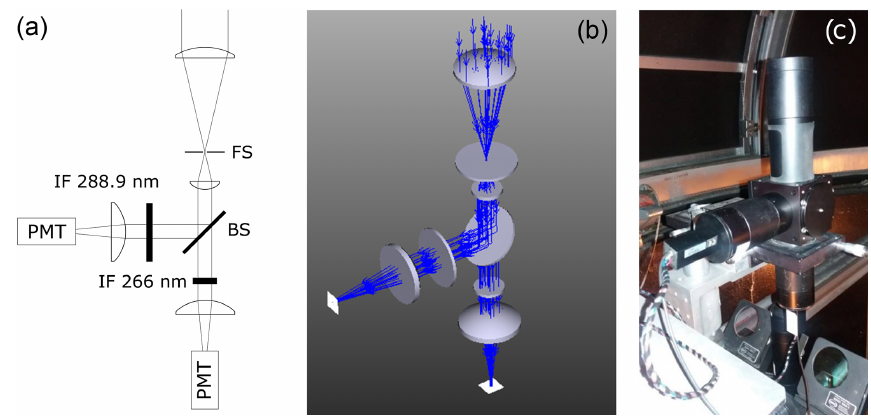
Figure 6. (a) Scheme of the new very near-range receivers. BS is a pellicle beam splitter, IF are interference filters and PMT are photomulti- pliers. (b) Photo of the actual setup. Motor-controlled mirrors corresponding to the main wavelength pair of the system (288.9/299.1nm) are shown on the bottom.